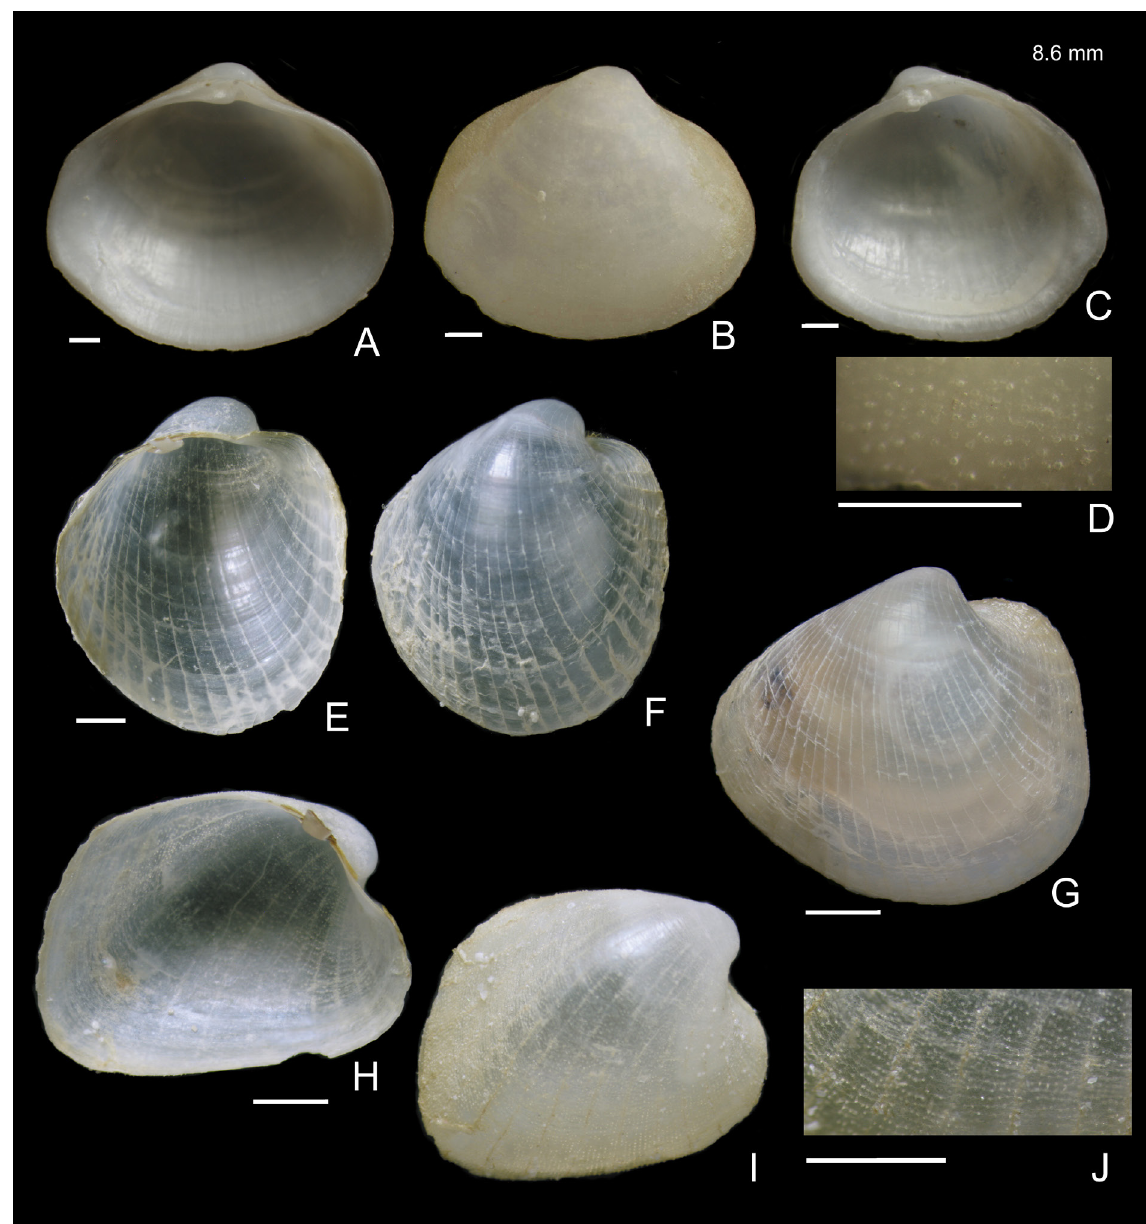
Fig. 39. Poromyidae, Lyonsiellidae. A–D . Poromya granulata (Nyst & Westendorp, 1839), SEAMOUNT 1, DW106, 765 m, 11.3 mm, 9.0 mm and 8.6 mm, and detail of the sculpture. E–F . Policordia gemma (Verrill, 1880), BANGAL 0711, V10, 1720 m, height 6.8 mm. G . Policordia sp., BANGAL 0711, V10, 1720 m, length 5.0 mm. H–J . Lyonsiella abyssicola (G.O. Sars, 1872), BANGAL 0711, V5, 1631 m, 5.0 mm, and detail of the sculpture. Scale bars = 1